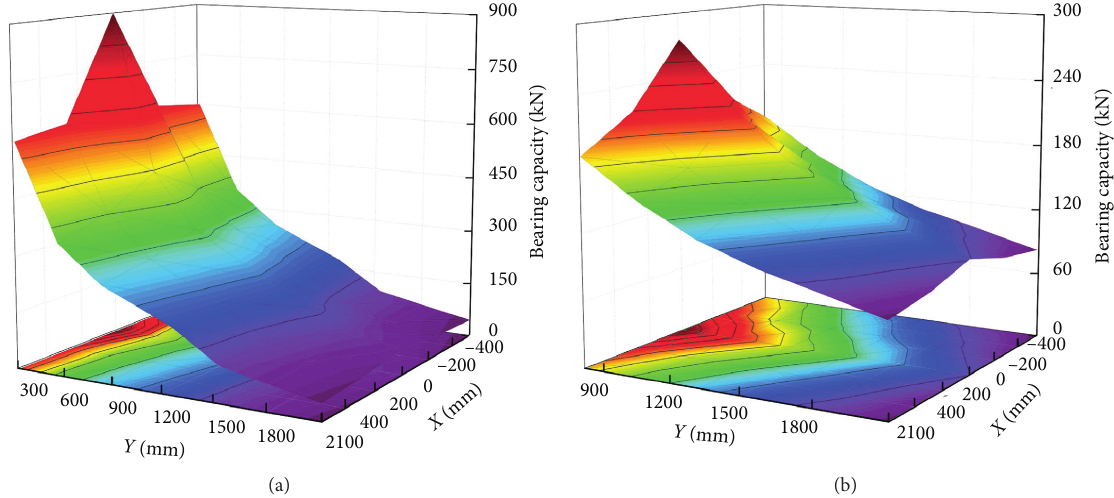
Figure 14: Curved surfaces of the bearing capacity of the face guard. (a) Bearing capacity curved surface of the integral face guard. (b) Bearing capacity curved surface of the split face